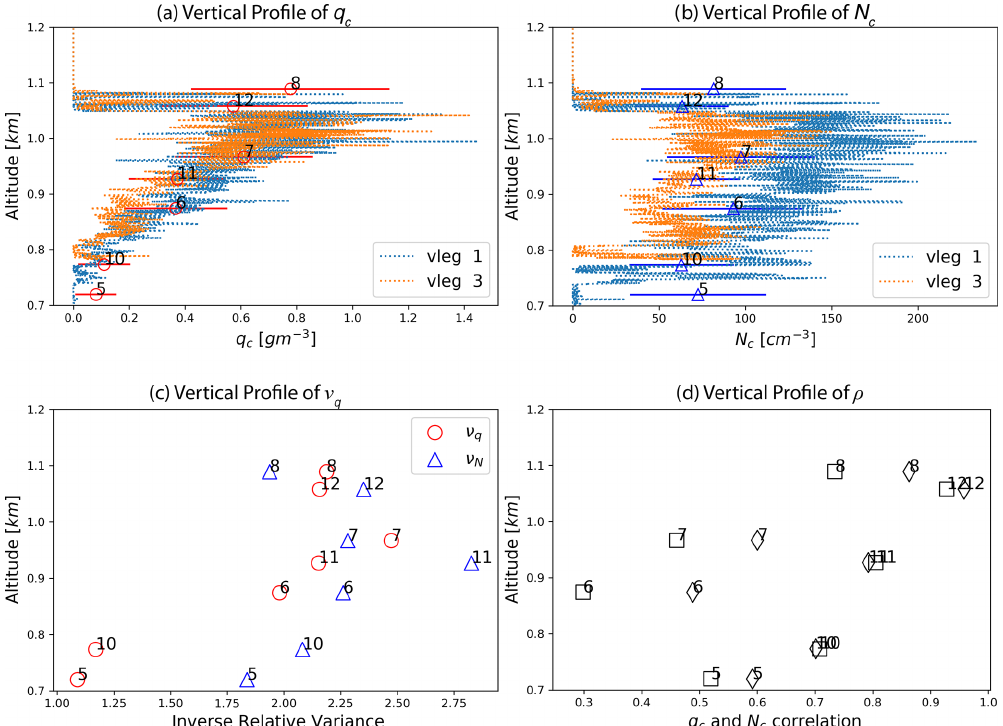
Figure 4. (a) The vertical profiles of q c derived from the vlegs (dotted lines) of the 18 July 2017 case. The overplotted red error bars indicate the mean values and standard deviations of the q c derived from the selected hlegs at different vertical levels. (b) Same as panel (a) except for N c . (c) The vertical profile of the inverse relative variances (i.e., mean divided by standard deviation) of N c (red circle) and N c (blue triangle) derived from the hleg; (d) the vertical profile of the linear correlation coefficient between ln (q c ) and ln (N c ) , i.e., ρ L (square), and the linear correlation coefficient between q c and N c , i.e., ρ